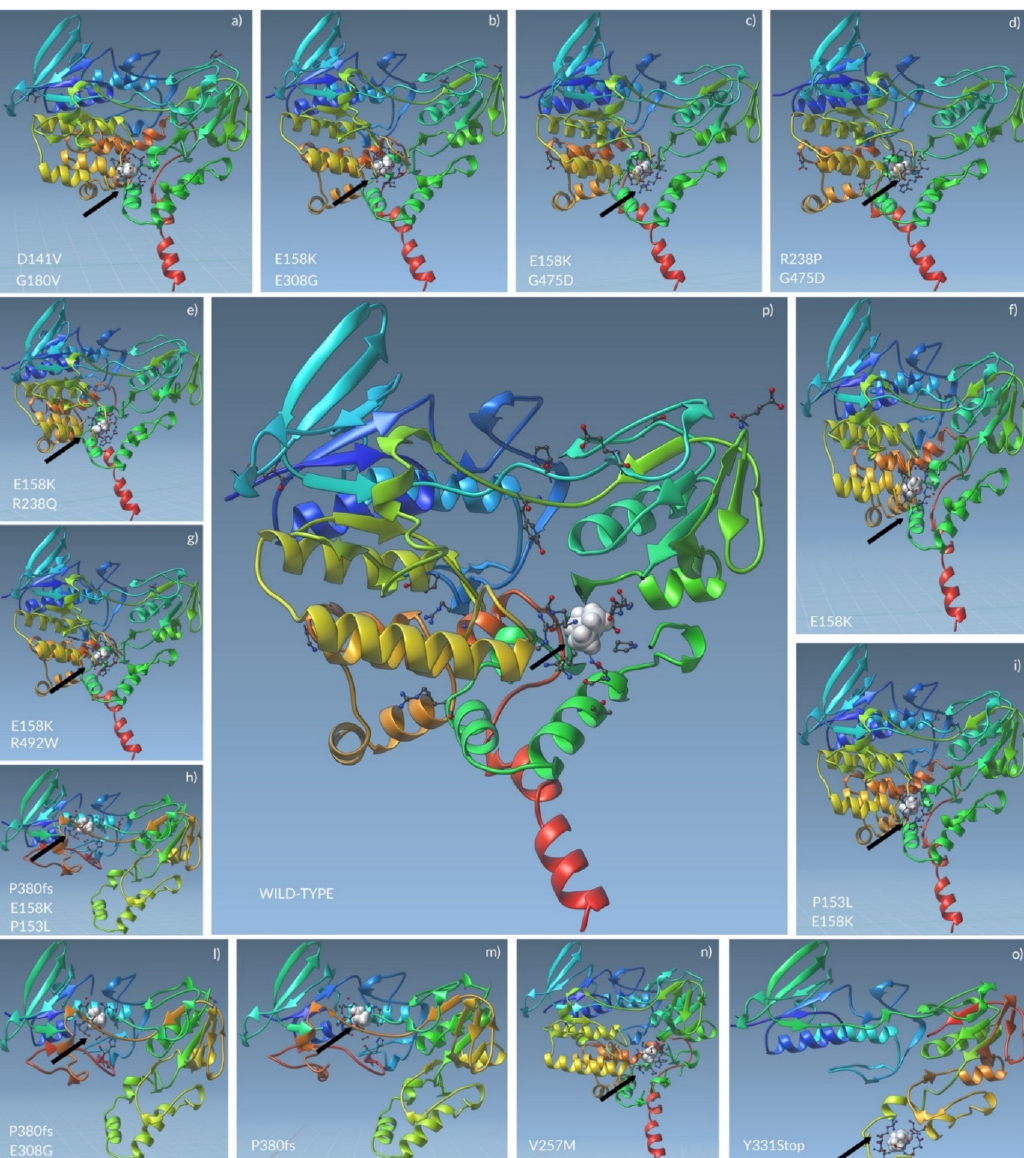
Figure 3. TMA docking to FMO3 could involve different amino acids in mutated enzymes. The non-sense and missense variants carried by mutated FMO3 ( a – o ) might shift the TMA binding sites far from the wild-type active site of the enzyme ( p ). The black arrows indicate the TMA (white spheres) bonded to the active site of FMO3 , whose aa are represented as ball-and-stick. The other aa, represented as ball-and-stick, separated from the ones in the catalytic site, are the aa involved in mutations.